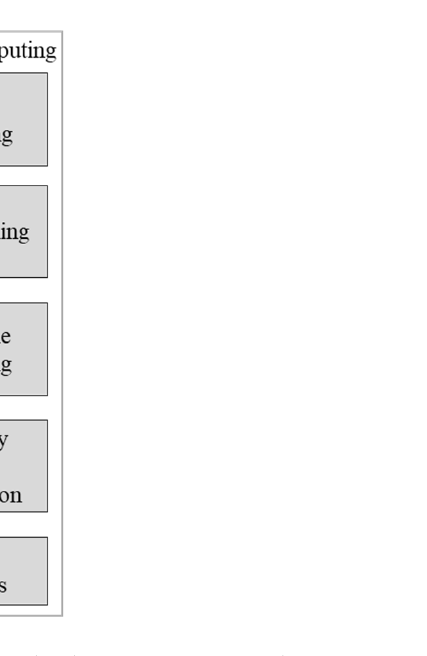
Figure 2. The integration of emerging technologies to generate and report transport security